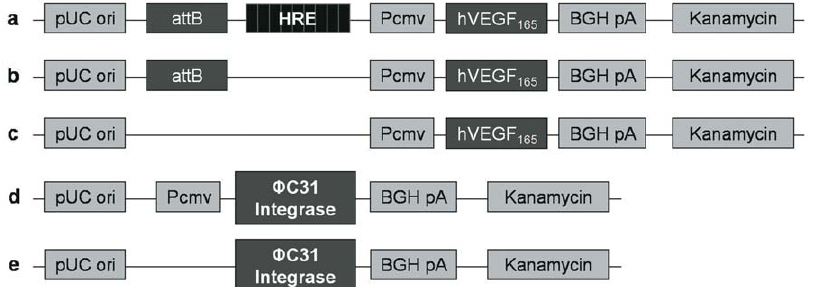
Figure 1. Schematic vector diagrams. (A) pVAX-HRE-attB-hVEGF165; (B) pVAX-attB-hVEGF165; (C) pVAX-hVEGF165; (D) uP-INT; (E) p-INT. pUC ori: replication origin. Pcmv: human cytomegalovirus promoter. BGHpA: polyadenylation signal of the bovine growth hormone. Kanamycin: kanamycin resistance gene.